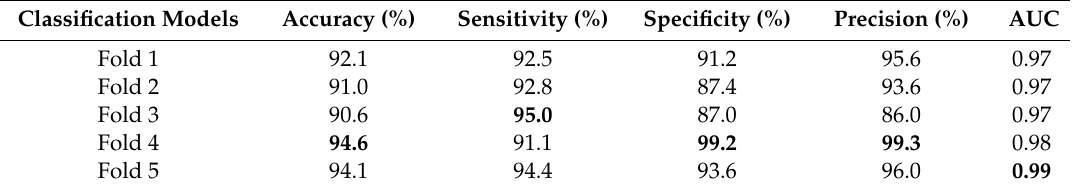
Table 6. Performance evaluation of the 5-fold cross-validation of the VGG19 model. Classification Models